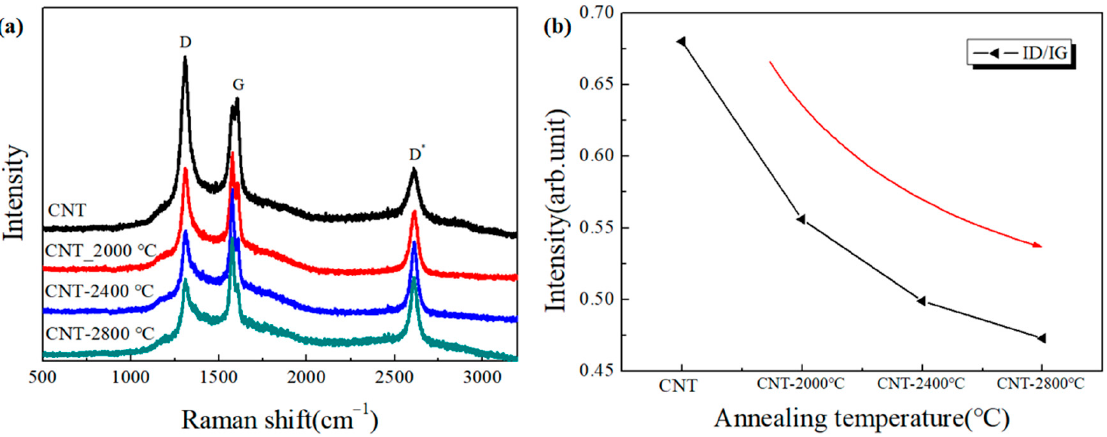
Figure 3. ( a ) Raman curves of MWNTs annealed at different temperatures for 180 min, ( b ) Ratio curves of D and G peaks in Raman.